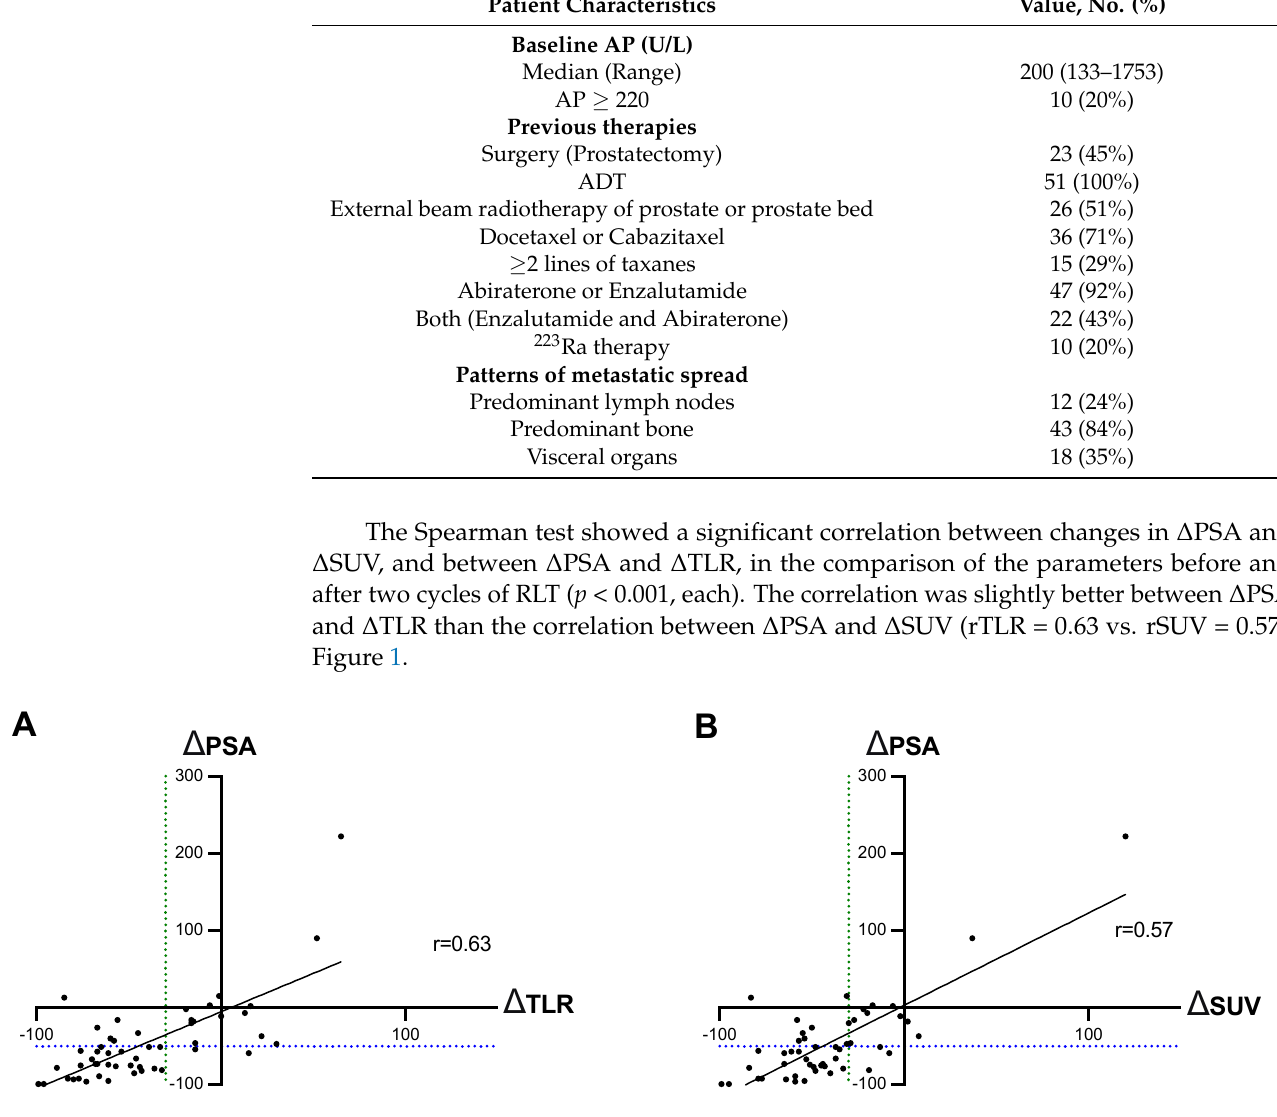
Figure 1. Correlation between ∆ PSA and ( A ) ∆ TLR and ( B ) ∆ SUV. The blue dotted line is localized at − 50% PSA change and the green dotted line at − 30% of TLR/SUV.